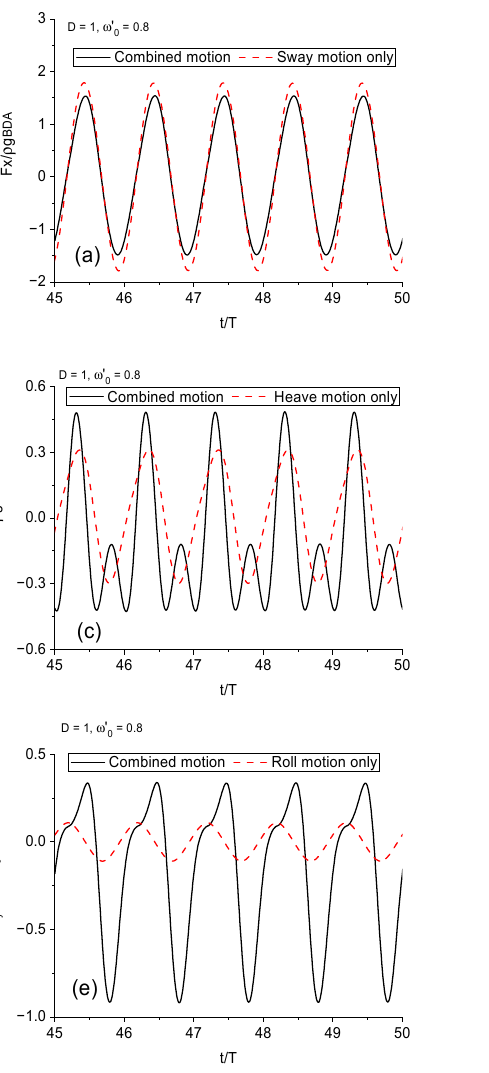
Figure 17. Development of free surface profile for the body under combined motion when 0 1.4